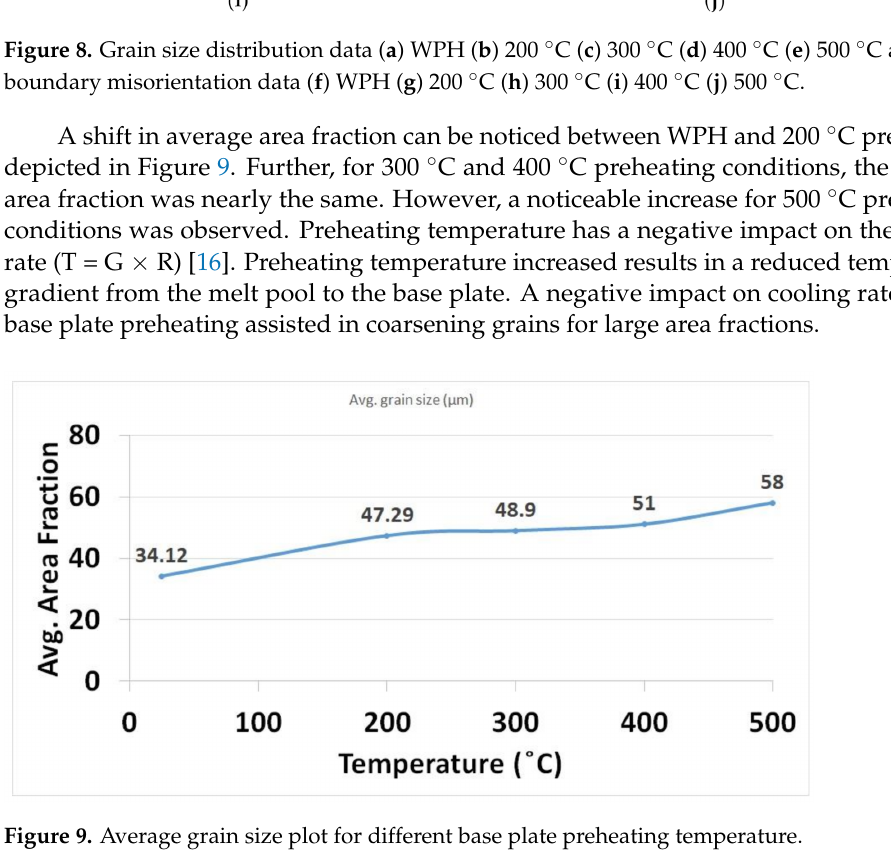
Figure 9. Average grain size plot for different base plate preheating